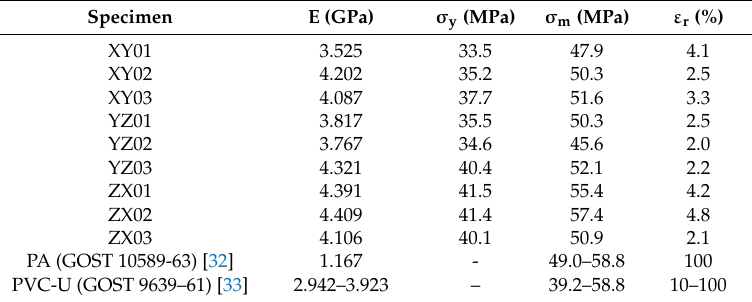
Table 4. Values obtained from tensile tests and reference values from Russian GOST normative 10589-63 [32] for PA and 9639-61 [33] for PVC-U.